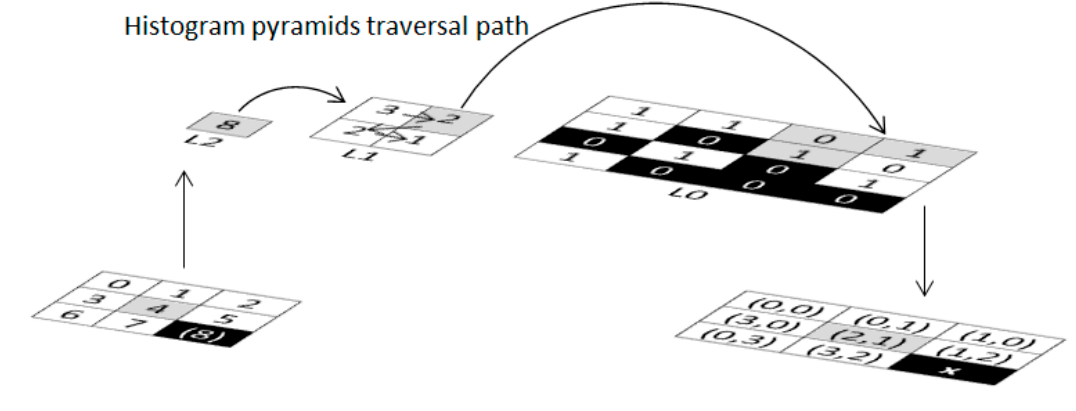
Figure 10. Histogram pyramids traversal.